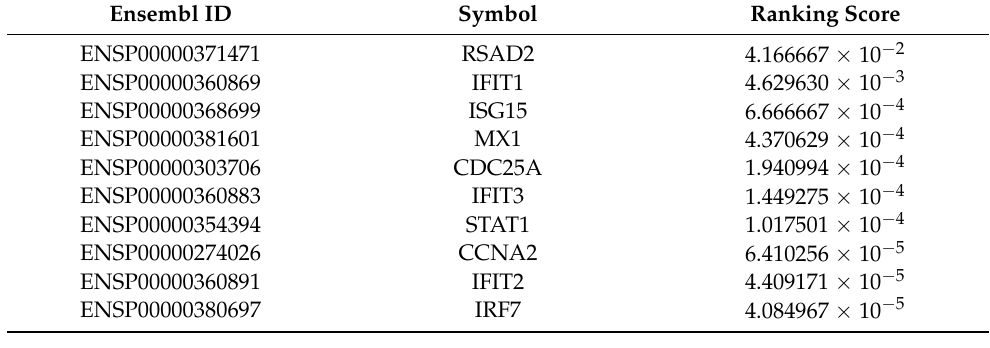
Table 4. List of nodes with high-ranking scores.